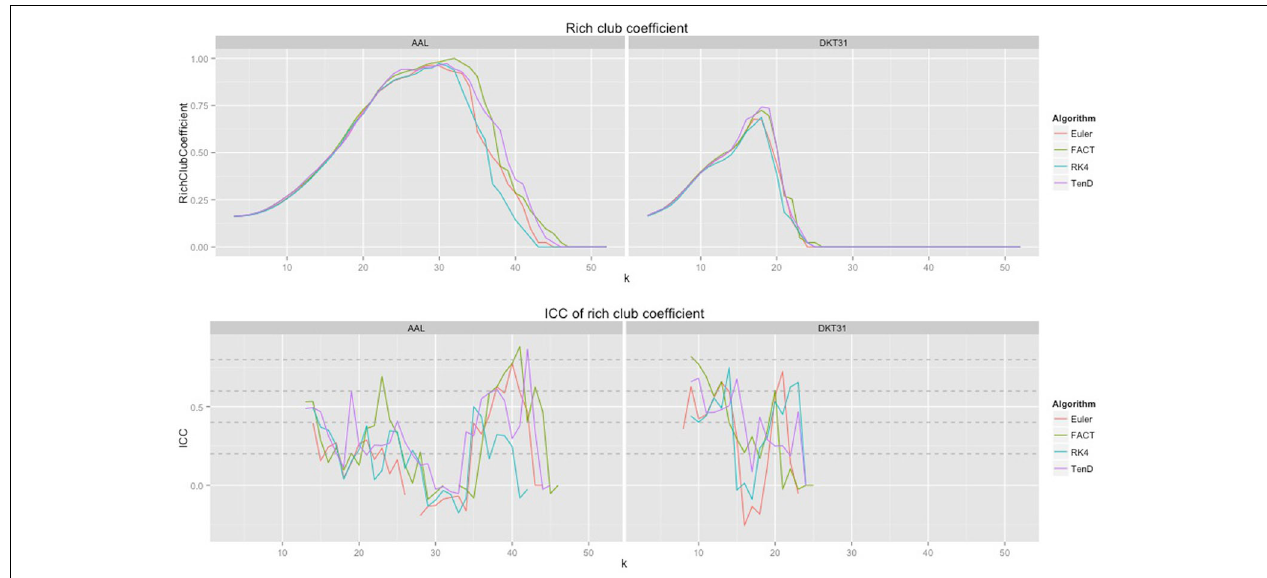
Only the first time-point for each subject is used. For each metric, the upper-triangular values are p-values for the AAL labels while the lower-triangular values were generated with the DKT31 label set ( ∗ indicates significance at p = 0.05).